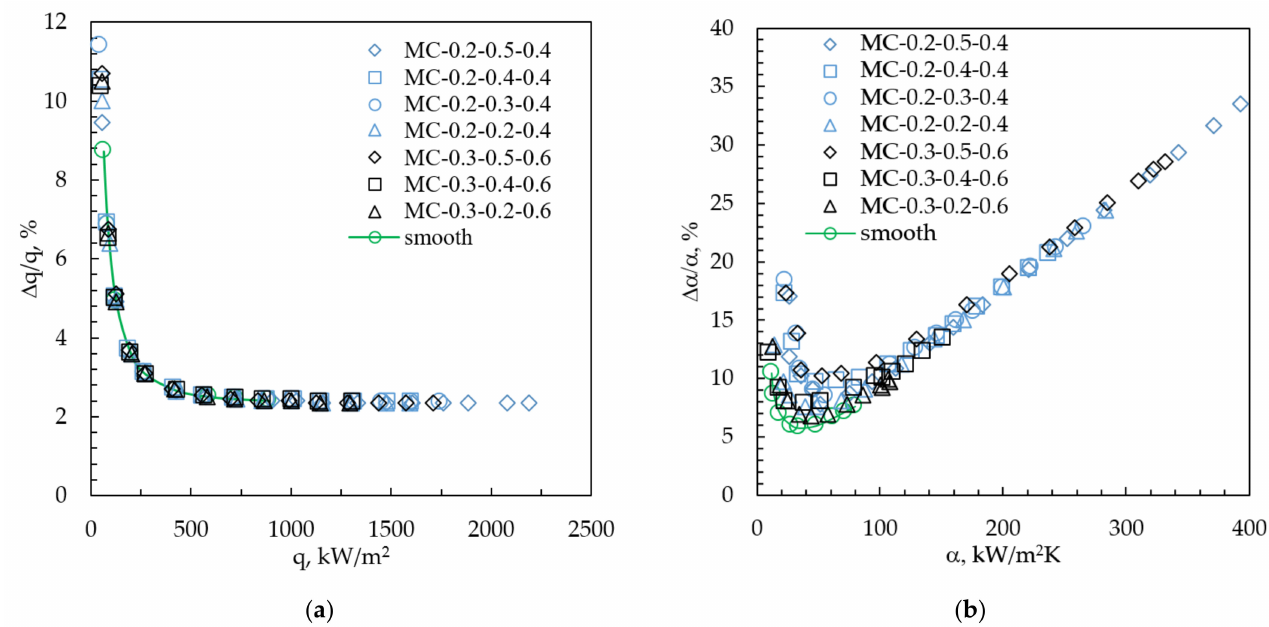
Figure 5. ( a ) Relative uncertainty at different heat fluxes; ( b ) relative uncertainties at different heat transfer coefficients.